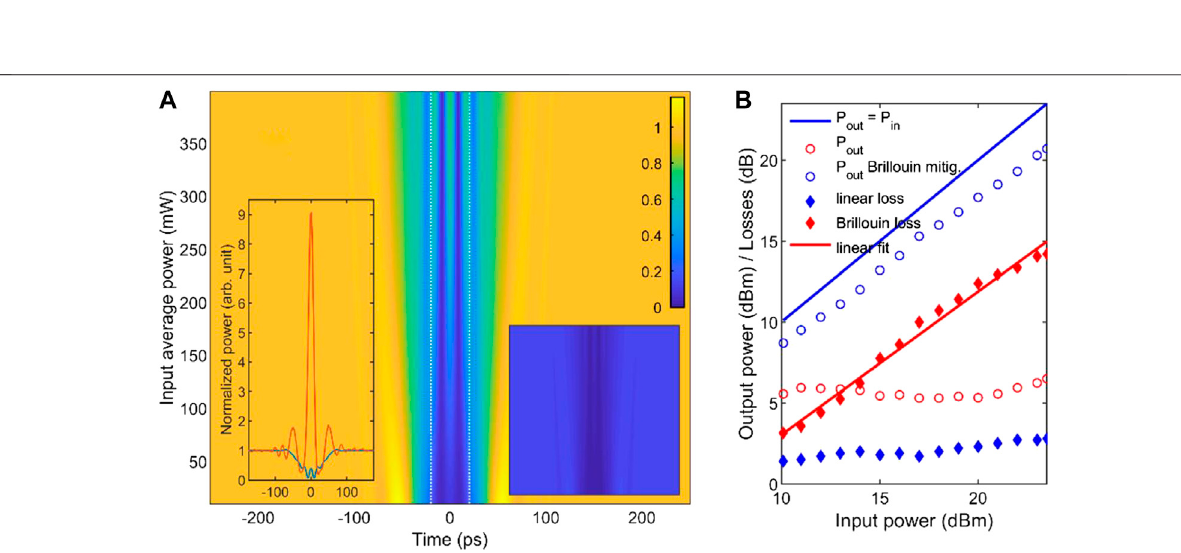
Frontiers in Physics |